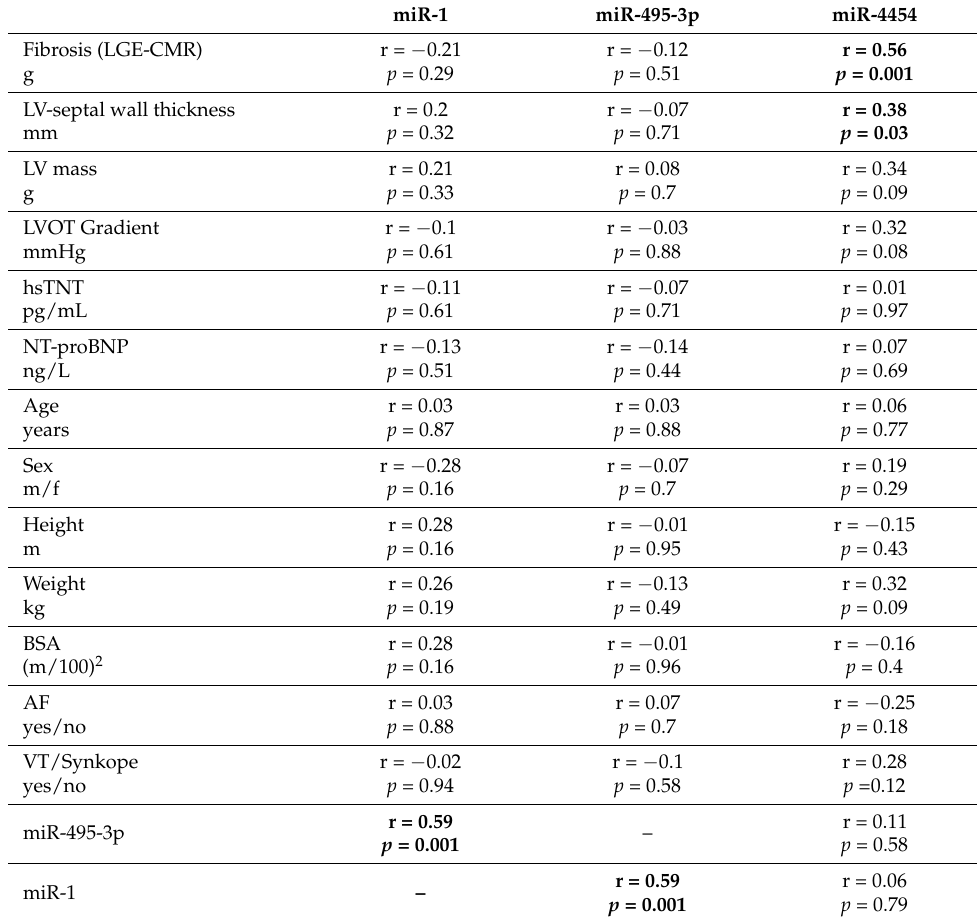
Table 3. Direct correlation of miRNA-4454 with fibrosis and septal wall thickness in entire cohort. miR-1 miR-495-3p